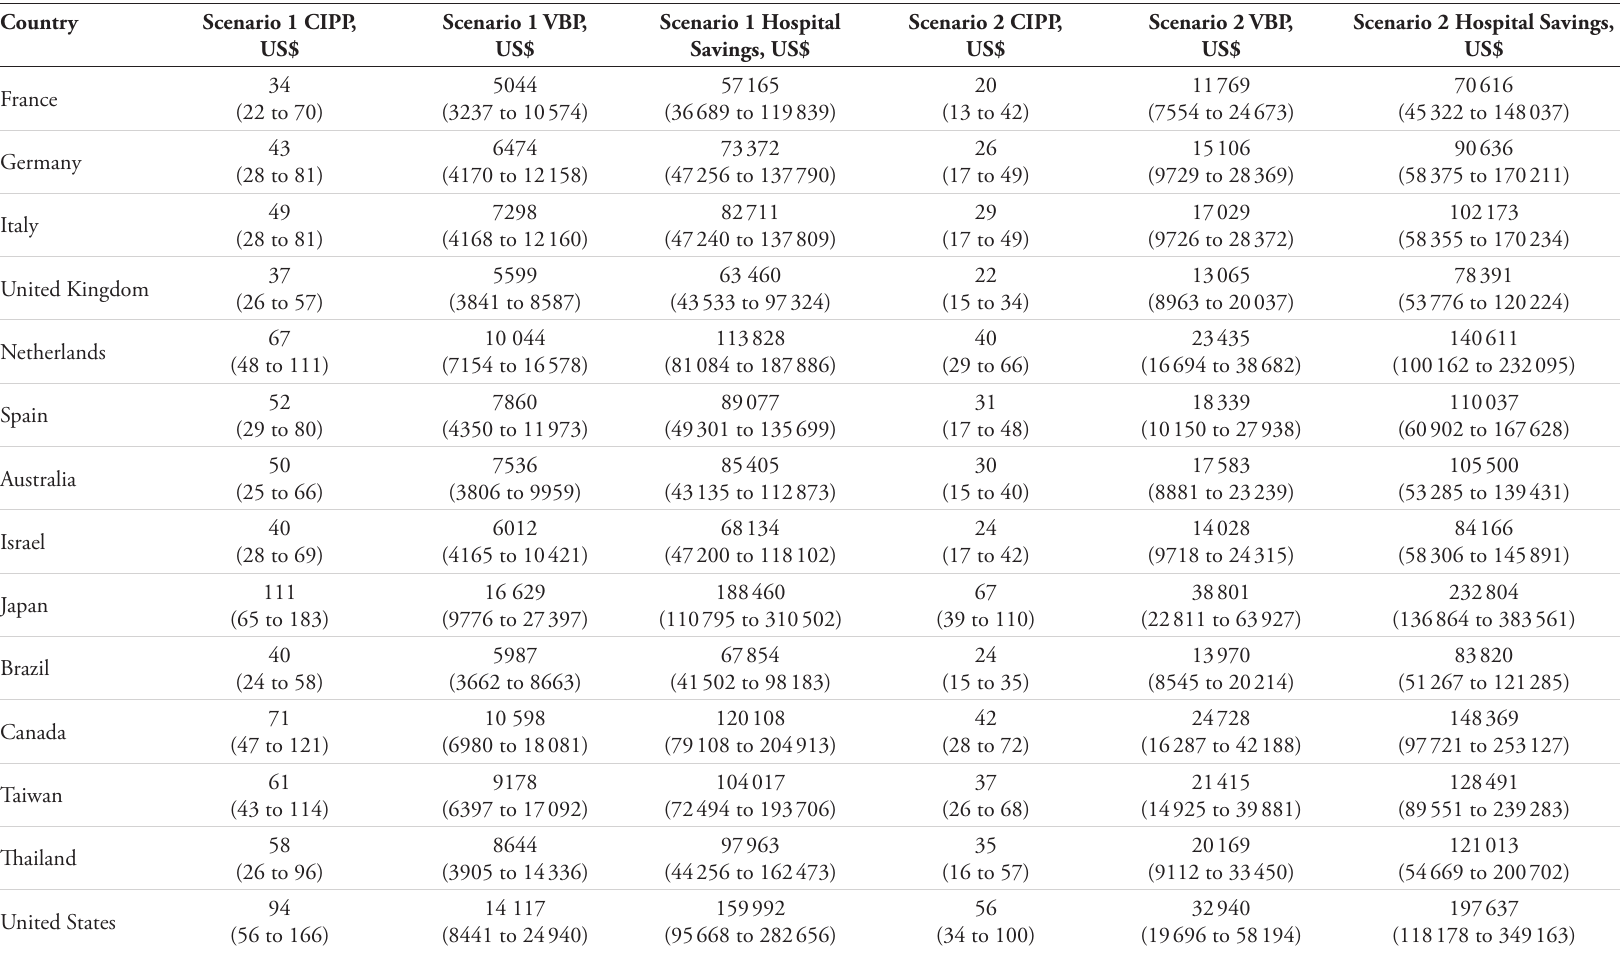
Table 3. Potential for VBP for a Hospital Performing 1000 CABG Procedures Per Year Across Analyzed Countries